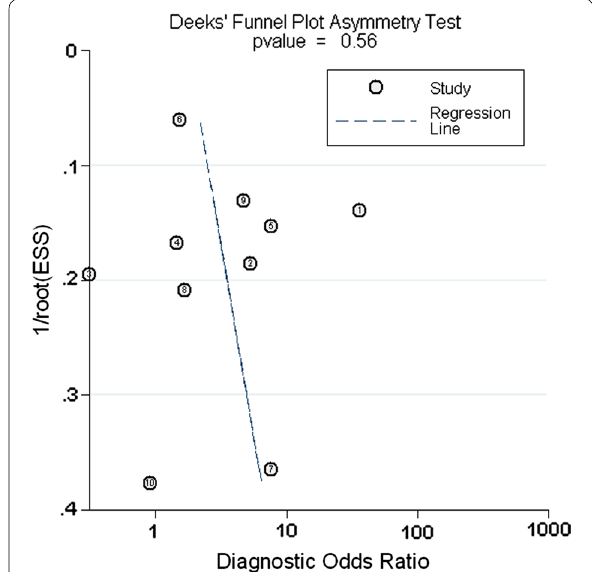
Fig. 3 Deeks’ funnel plot for detecting publication bias. ① Heine- mann et al.; ② Wistokat-Wülfing et al.; ③ Lorenzini et al.; ④ Darsow et al.; ⑤ Kutlu et al.; ⑥ Manzini et al.; ⑦ Wananukul et al.; ⑧ Michel et al.; ⑨ Holm et al.; ⑩ Fuiano et